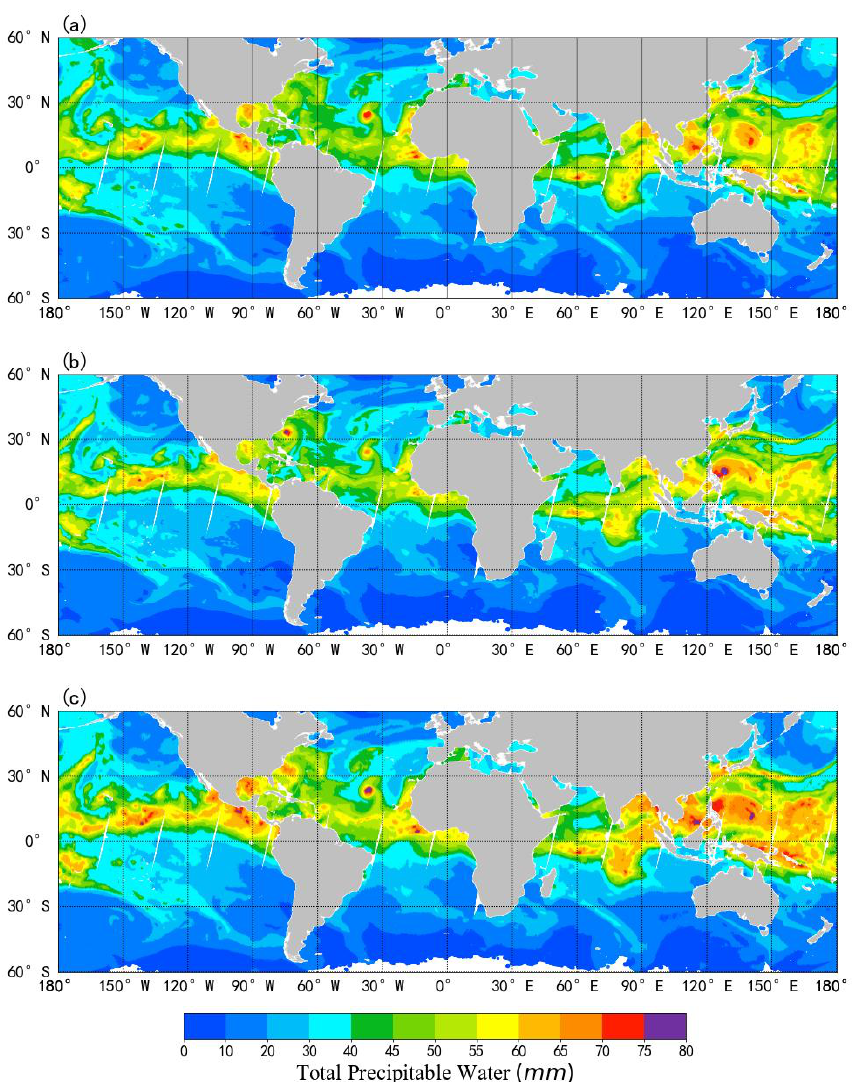
Figure 7. TPW retrieved from ATMS over global oceans on 13 September 2018 using ( a ) physical algorithm; ( b ) ERA5 reanalysis data; ( c ) statistical algorithm.